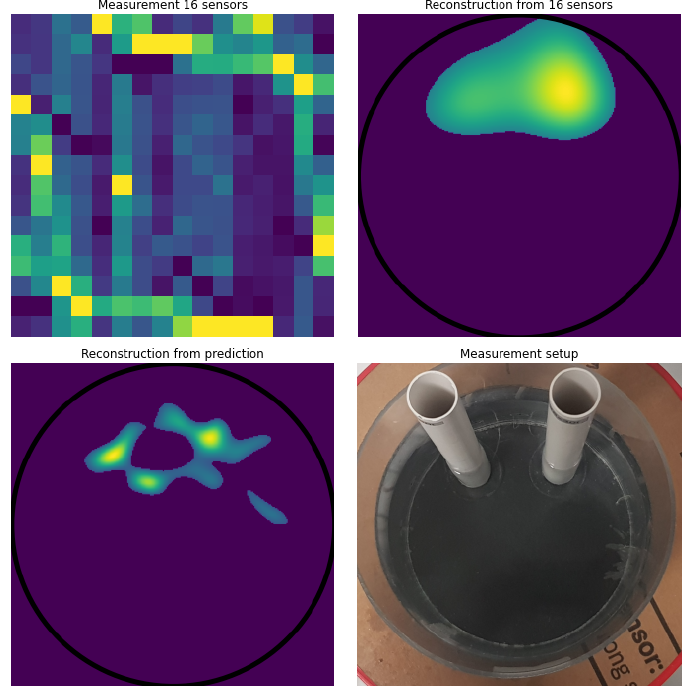
Figure 10. The results obtained from real measurements with two phantoms located in the circular tank using the second network shown in Figure